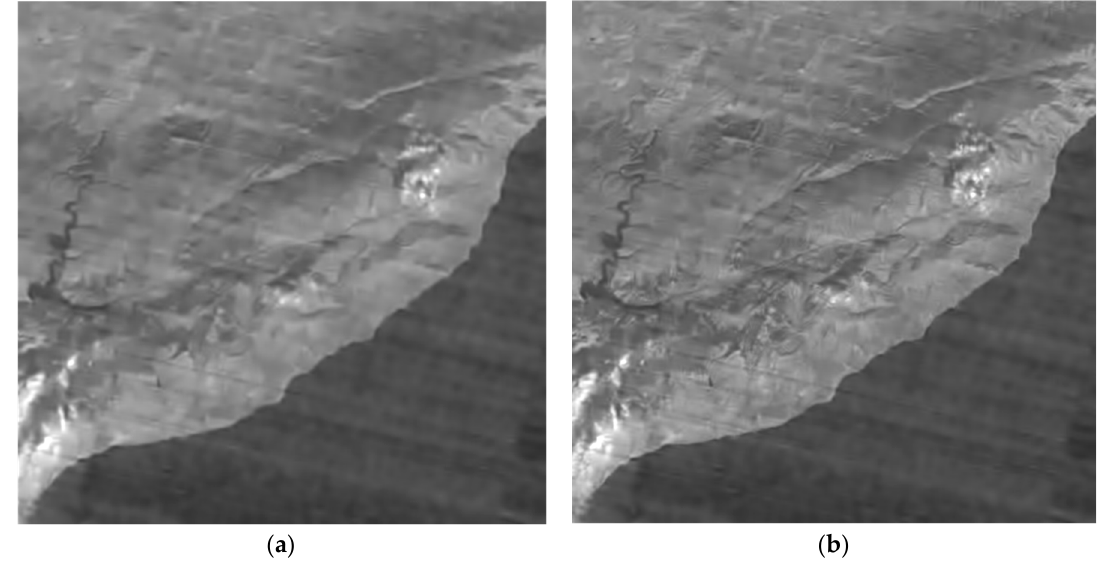
Figure 10. Output image for filtering with one ( a ) and two ( b ) nonlinearly transformed references (component image in channel #11 and component images in channels ##11 and 12).